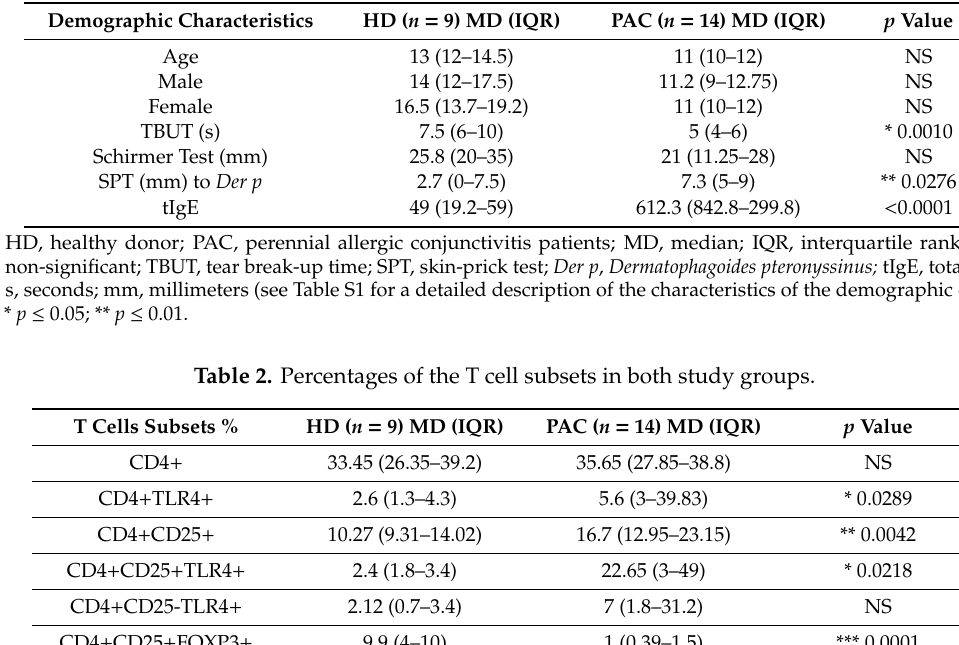
Table 1. Demographic characteristics of the subjects included in this study.